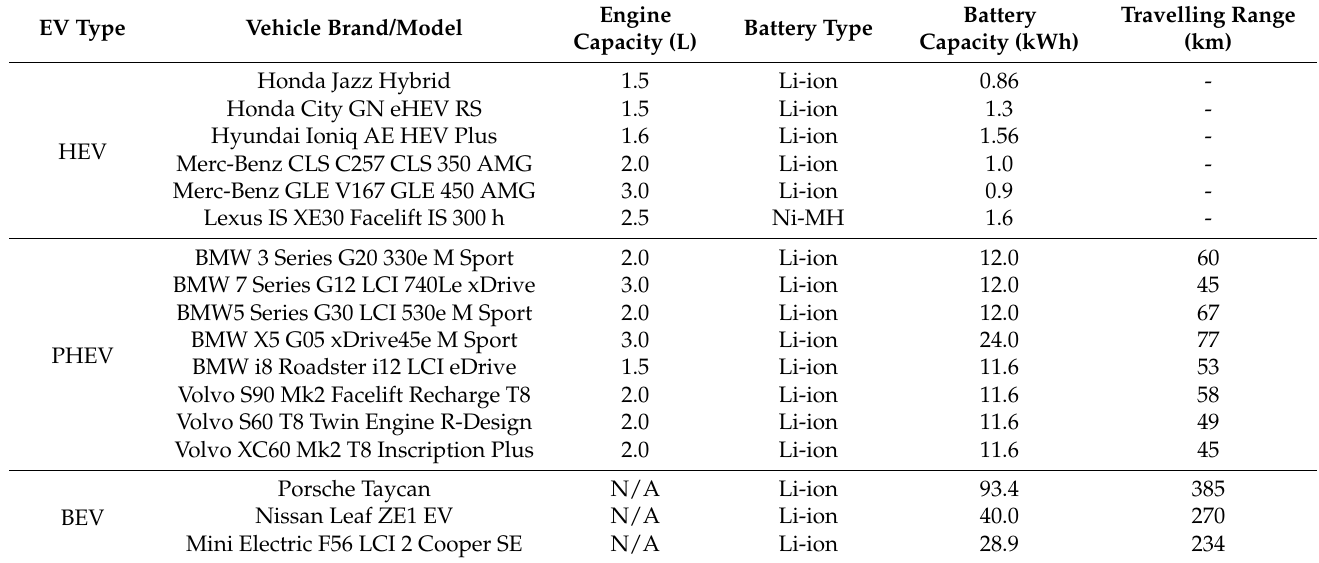
Table 1. Among the EV models available in the Malaysian market as of August